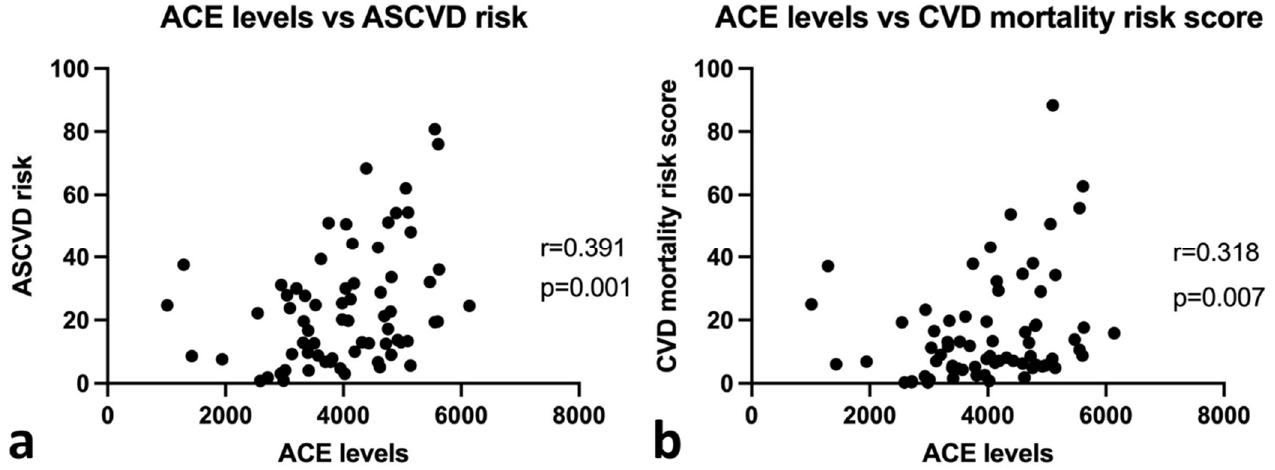
Figure 2. Correlations between ACE levels with ASCVD risk score and cardiovascular mortality score with Spearman analysis. ( a ) Correlation between ACE levels with ASCVD risk score. ( b ) Correlation between ACE levels with cardiovascular mortality score. Table 3. Results of the correlational analysis between variables in this study.